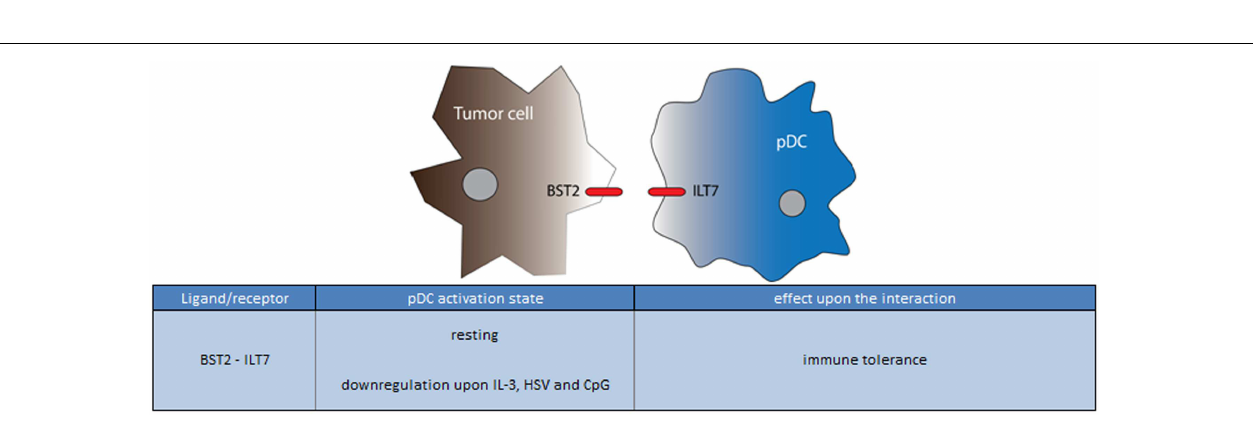
FIGURE 9 | Ligand/receptor paring of a pDC with a tumor cell and the maturation state/activation stimuli associated with ligand or receptor expression on the pDC surface .